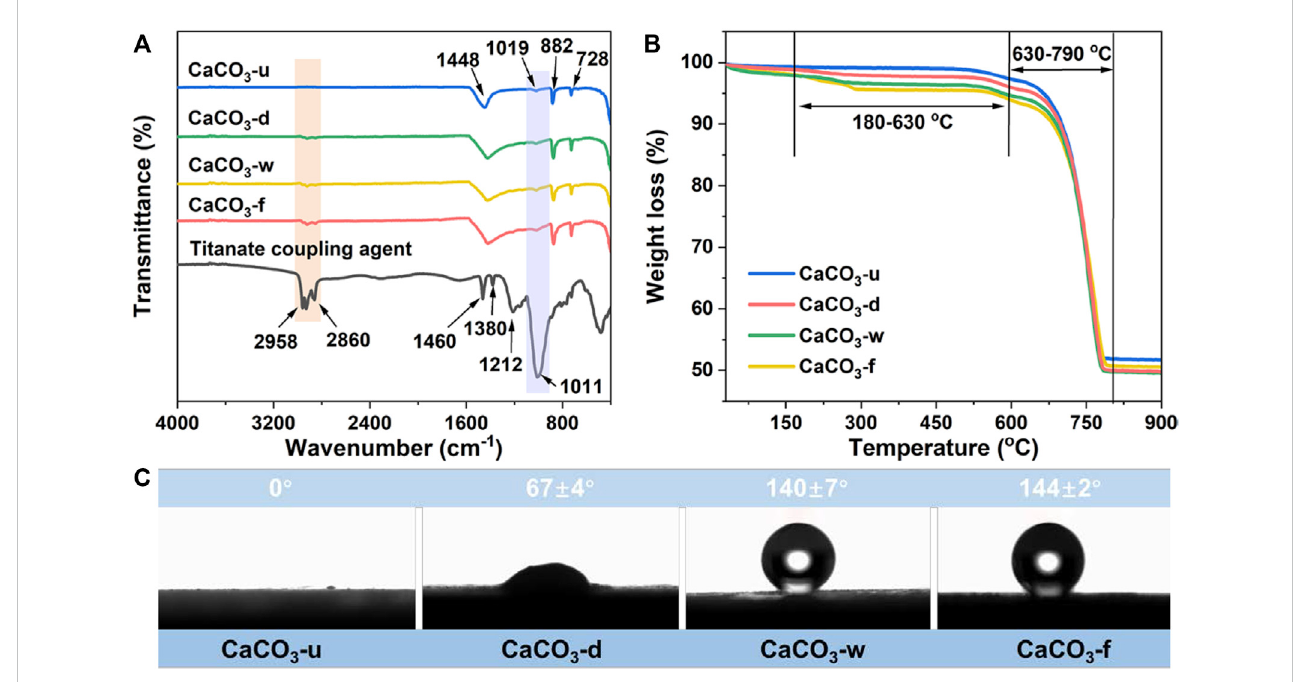
FIGURE 2 (A) FT-IR spectroscopy, (B) TGA, and (C) Water contact angle of CaCO 3 samples prepared by different modi fi cation